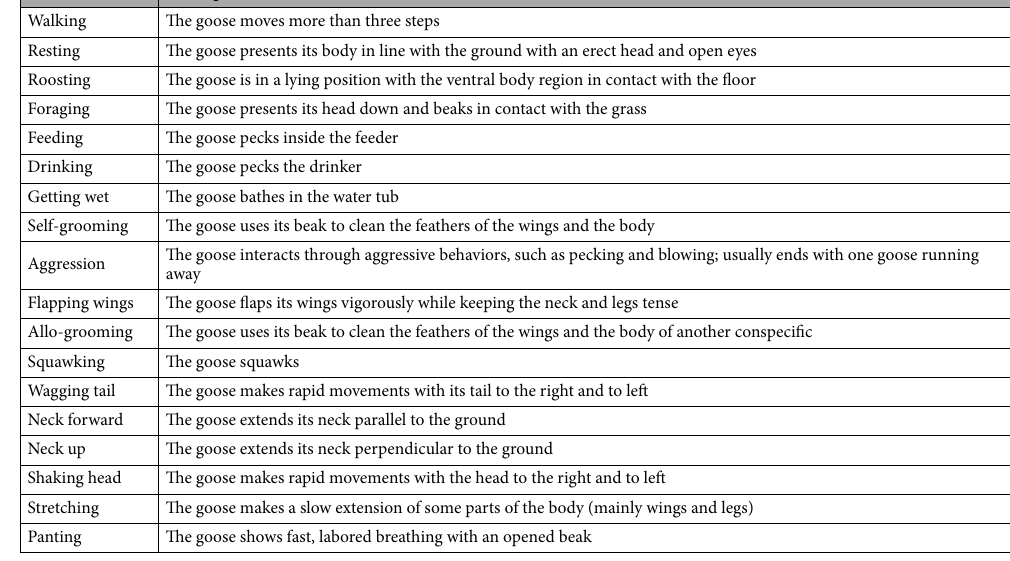
Table 5. Ethogram of recorded behaviors of